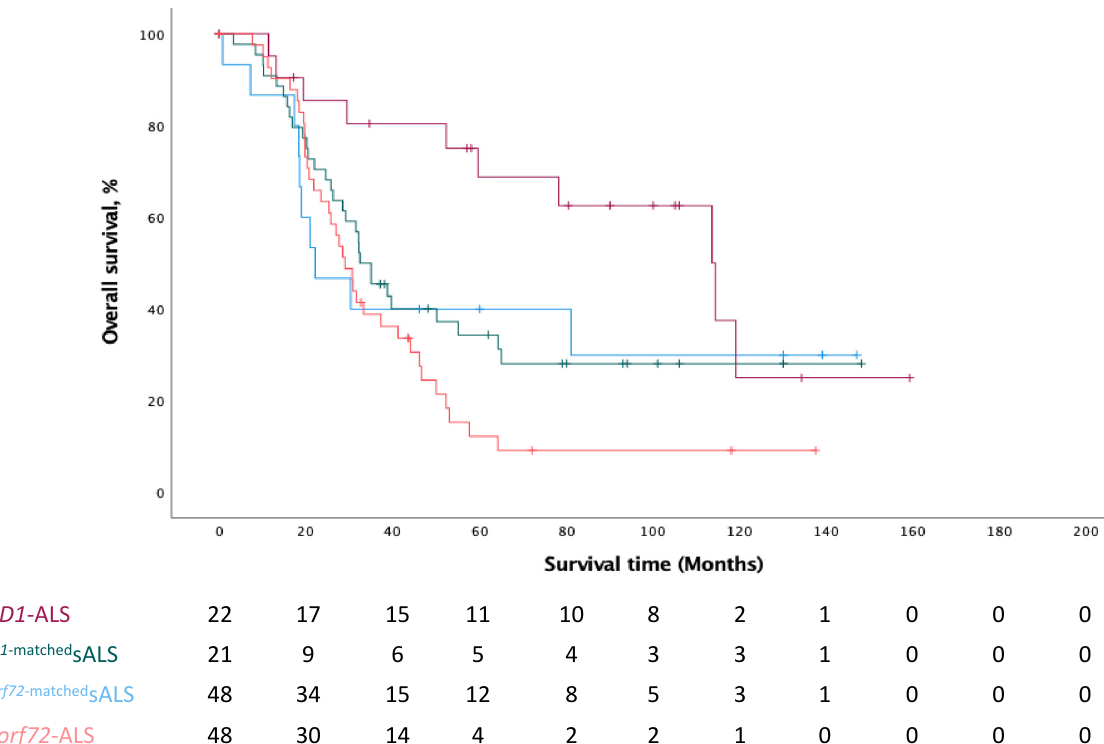
Figure 1. Kaplan–Meier plot of overall survival by ALS group. A log rank test revealed a significantly different distribution in survival for the different ALS groups, χ 2(3) = 11.130, p = 0.011. Log rank pairwise comparisons were done with a Bonferroni correction, with statistical significance accepted at the p < 0.0125 level. There was a significant difference in survival distribution for SOD1 -ALS and C9orf72 -ALS patients ( p = 0.0002).